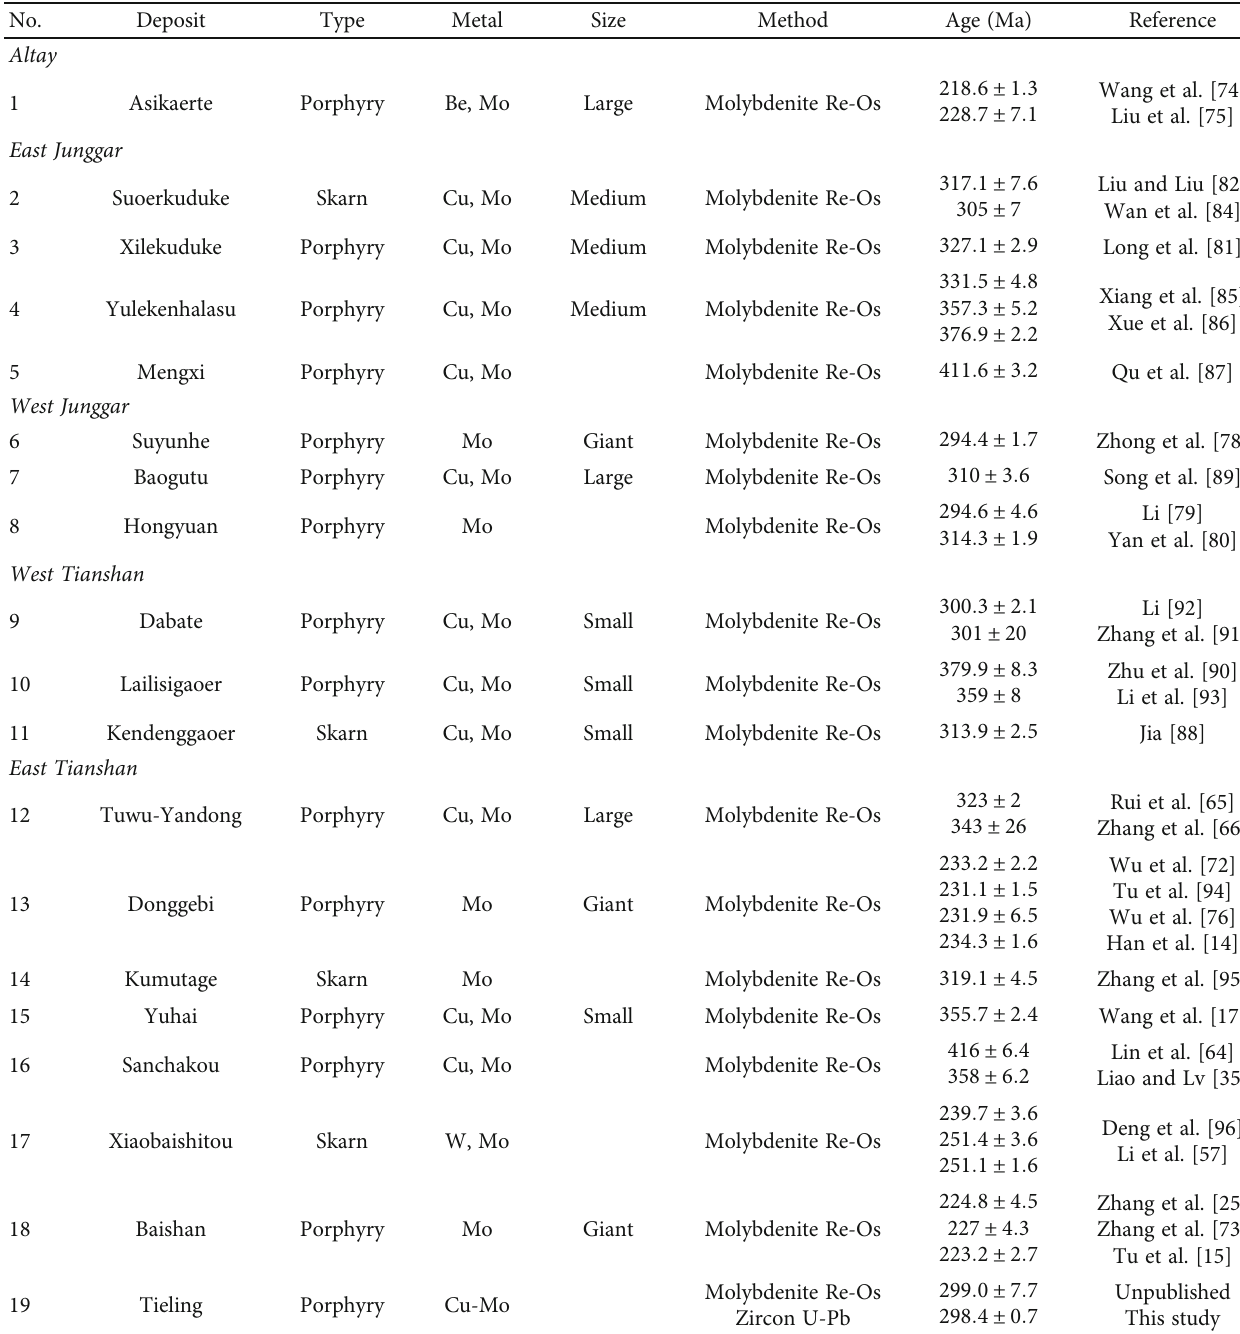
Table 4: Molybdenite Re-Os isochron ages of Mo deposits in northern Xinjiang, NW China.